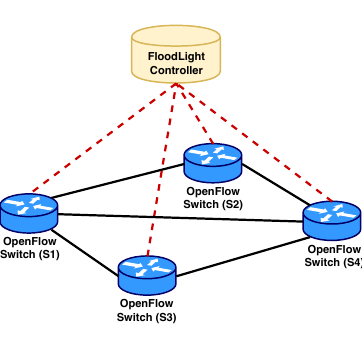
Figure 1. Biconnected Topology